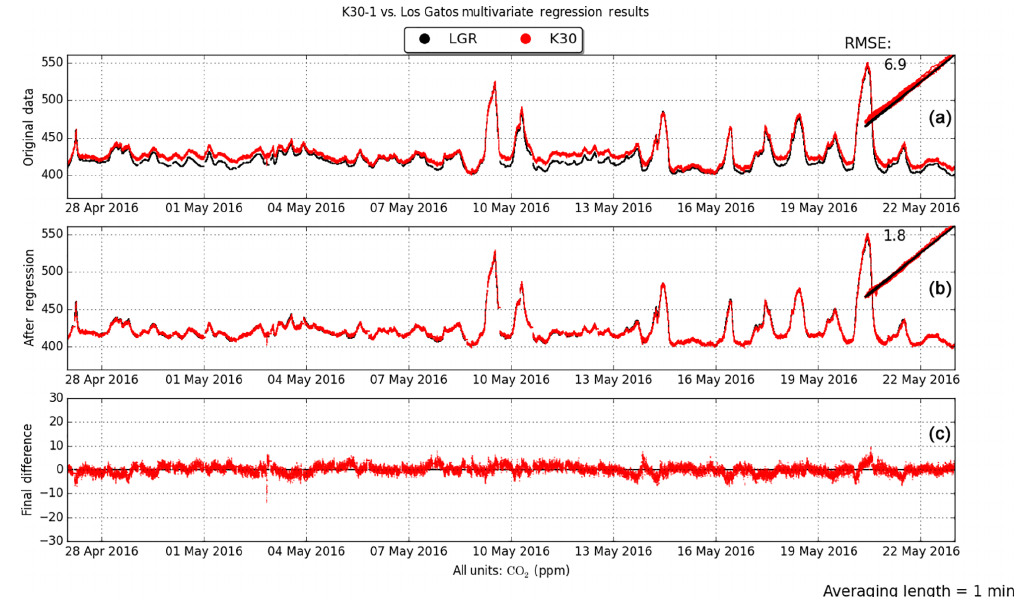
Figure 8. A continuous time series of 1min averages as well as scatter plots for K30-1 compared to the LGR for the multivariate regression described in Sect. 5.2. (a) The original data, (b) final time series after correction and the (c) difference plot between the corrected K30 dataset and the original LGR dataset. The root mean square error (RMSE) of the K30 data compared to the LGR before and after the regression is annotated to the upper left of the scatter plot.